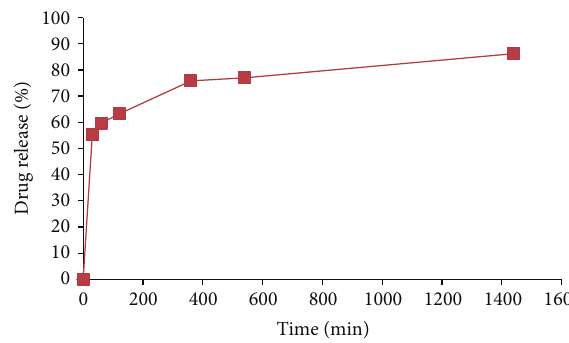
Figure 10: In vitro release profile of amoxicillin from porous hollow silica nanospheres (std. deviation =